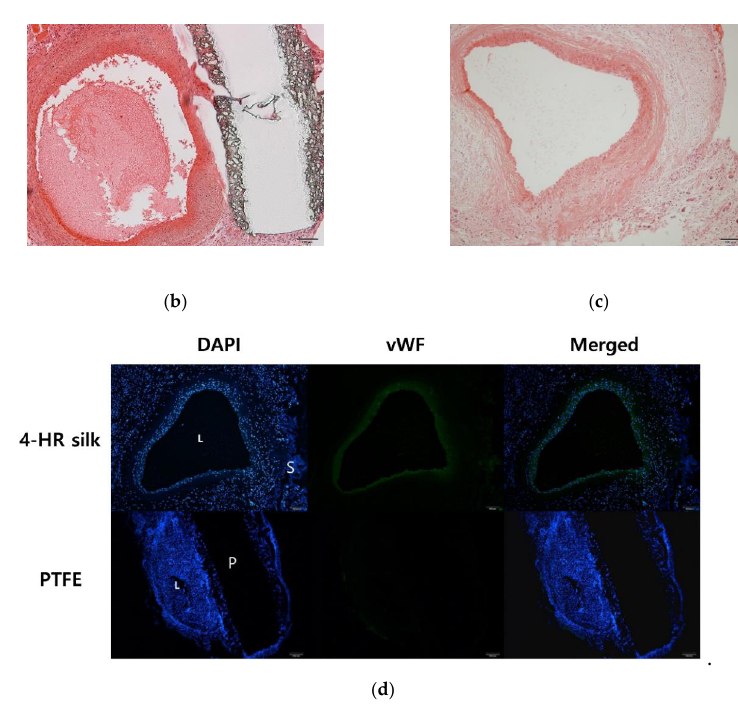
Figure 4. ( a ) Repair of an artificial artery defect using a vascular patch. Histological view (hematoxylin and eosin stain) of ( b ) polytetrafluoroethylene (PTFE) group and ( c ) 4-HR silk group; ( d ) fluorescent view of von Willebrand factor (vWF) expression. (L: lumen; S: silk patch; original magnification ×100; scale bar = 100 µm). Reprinted with permission [12].